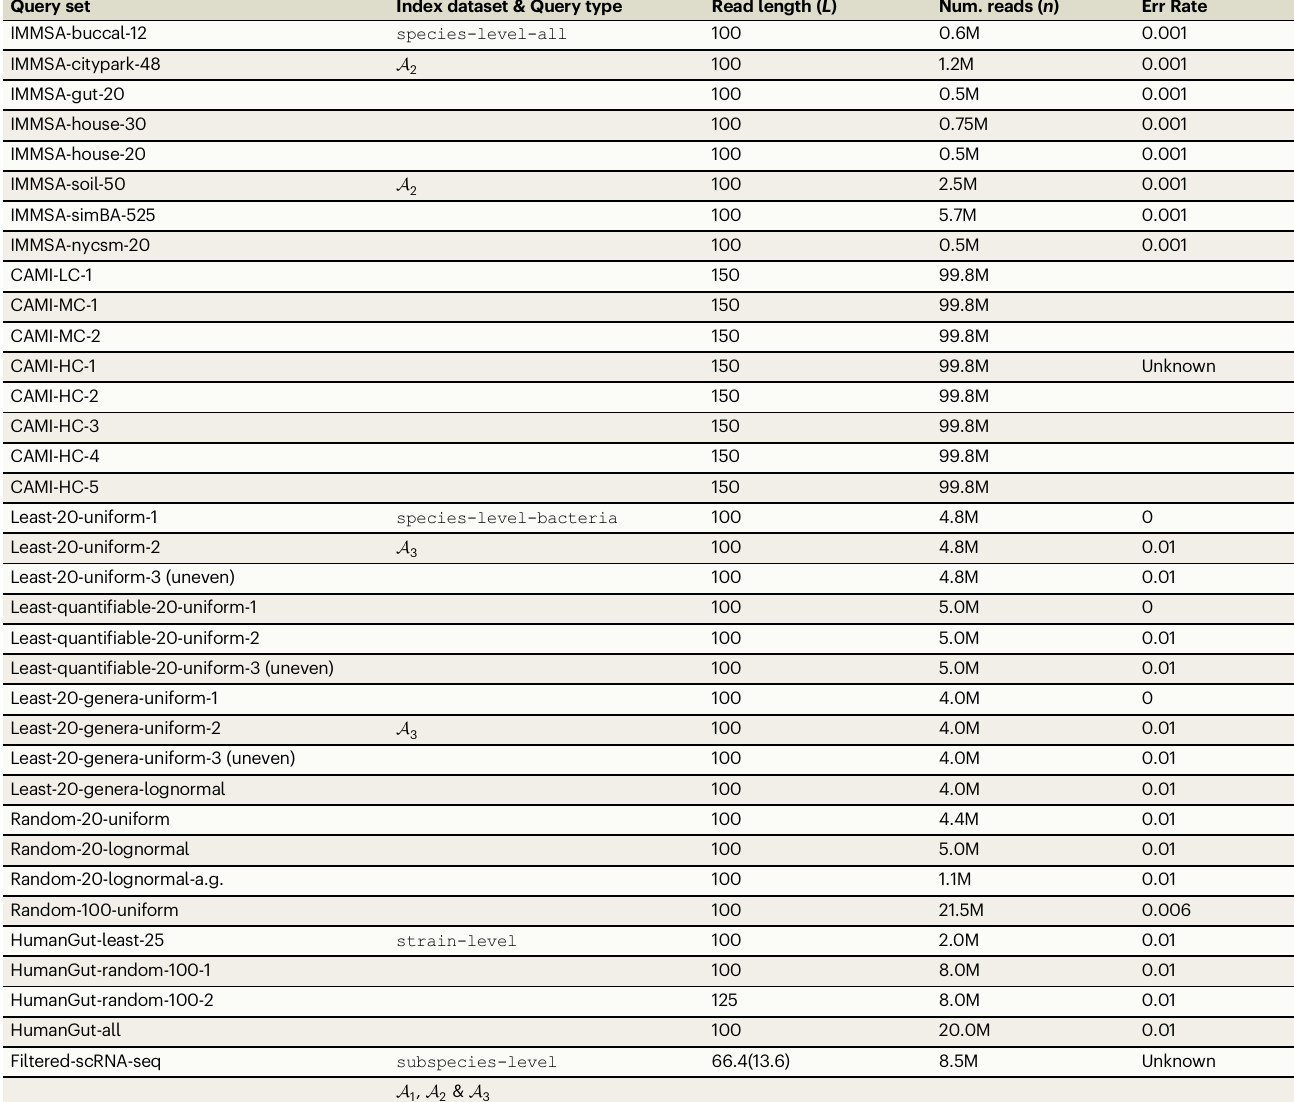
Table 1 | Synthetic and real bacterial read sets used to benchmark CAMMiQ ’ s performance against the best performing metagenomic classi fi cation and abundance estimation